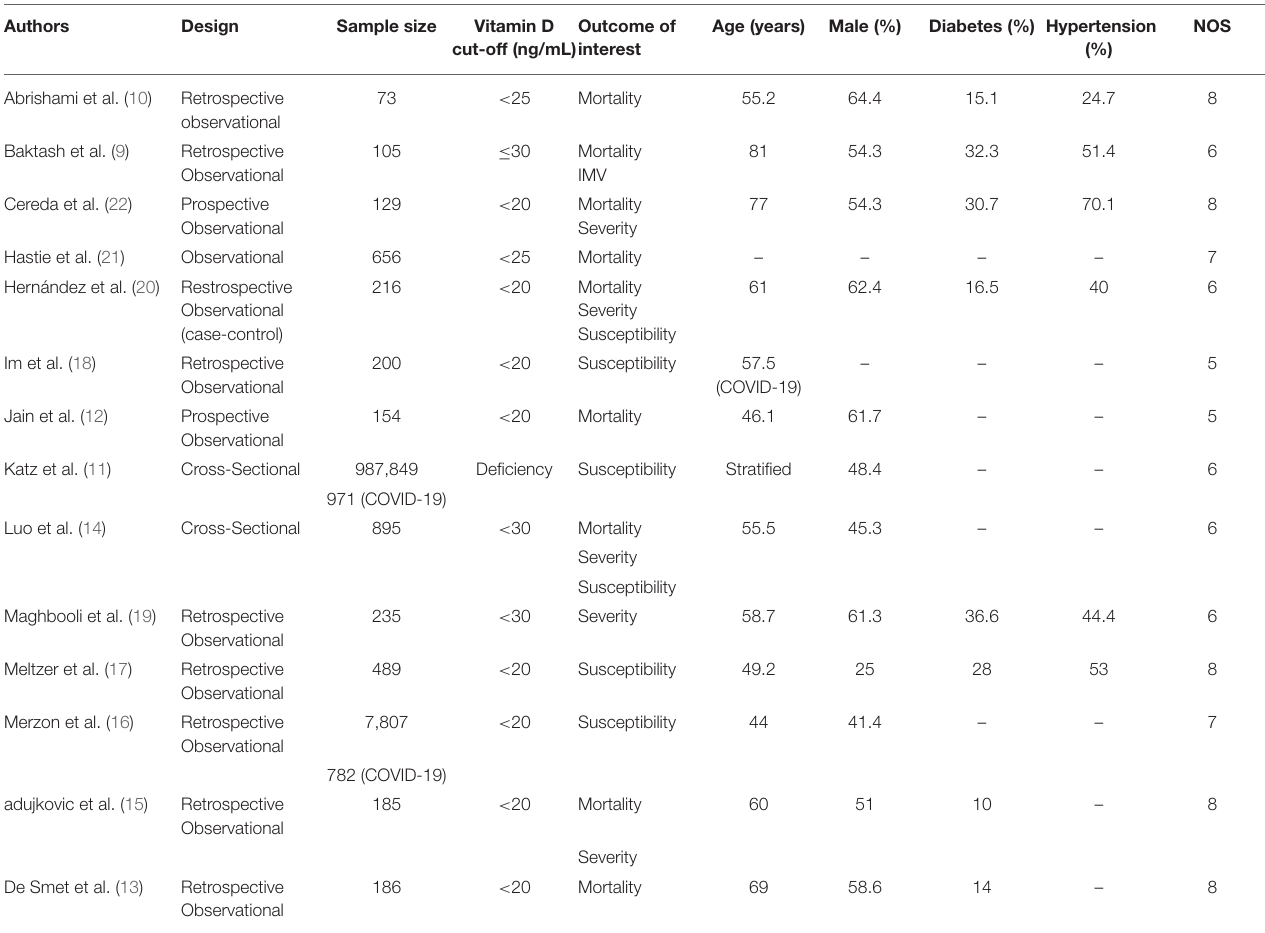
TABLE 1 | Baseline characteristics of the included